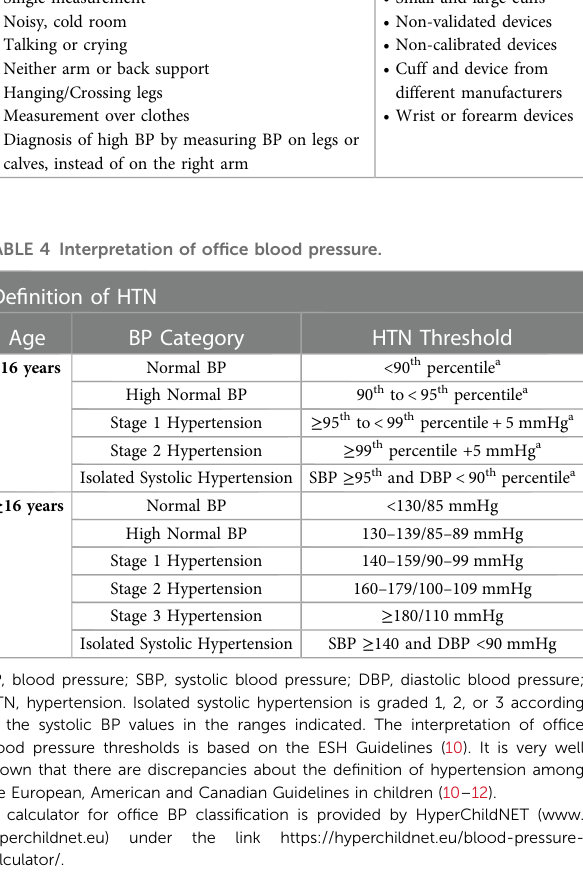
TABLE 3 Common mistakes during of fi ce blood pressure measurement. Methodology